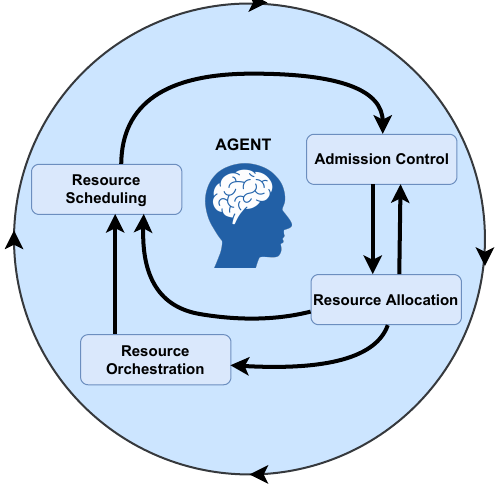
Figure 2. Resource management